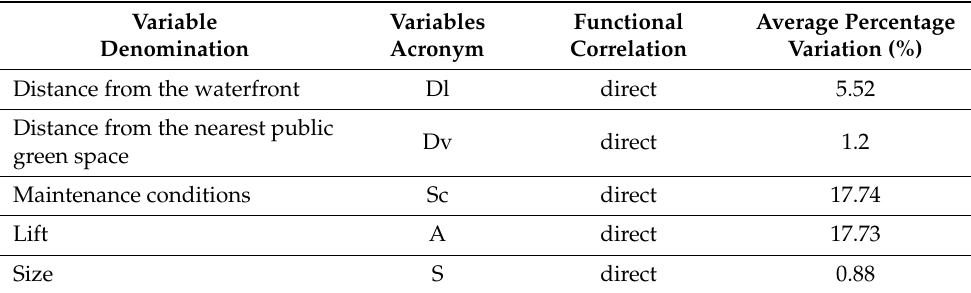
Table 6. Total selling prices average percentage variation for the variables chosen by the model for the OMI suburban area of the city of